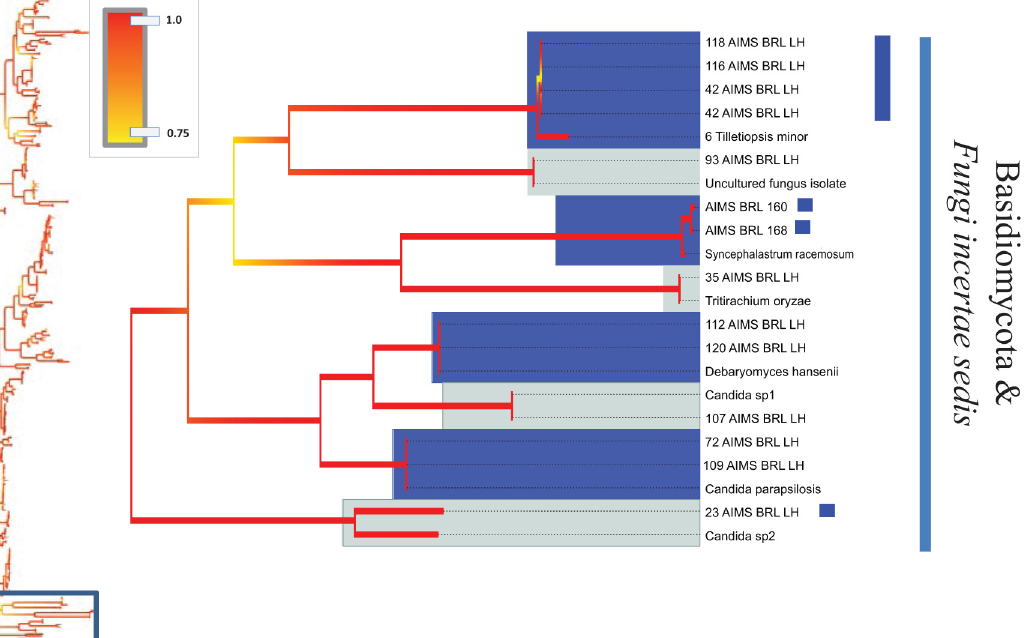
Fig 7. Bayesian phylogenetic hypothesis inferred from ITS barcodes produced in this study and corresponding best BLAST results. Subsection of tree focused on Basidiomycota and Fungi incertae sedis isolates. Alternating dark blue and grey blocks are intended to visually differentiate reciprocally monophyletic OTUs. Yellow-to-red colour gradient denotes posterior probability support throughout the topology. Blue boxes denote unknown isolates.